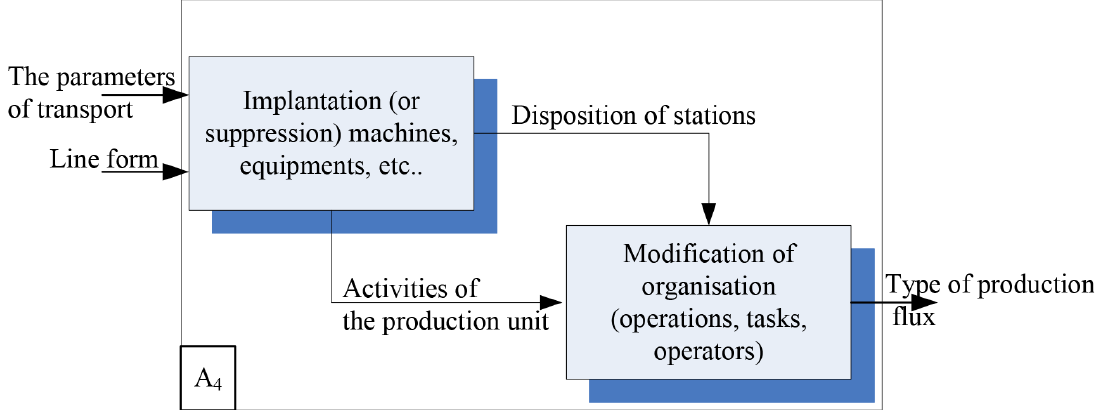
Figure 9. Activity A